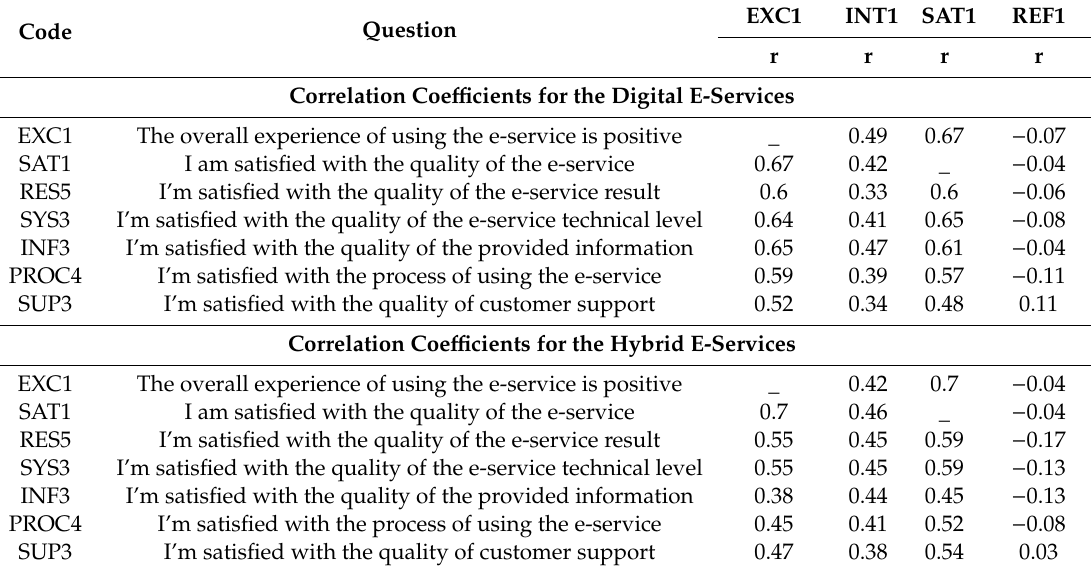
Table 6. Correlation and regression relationships of the crucial components of the model for the digital and hybrid